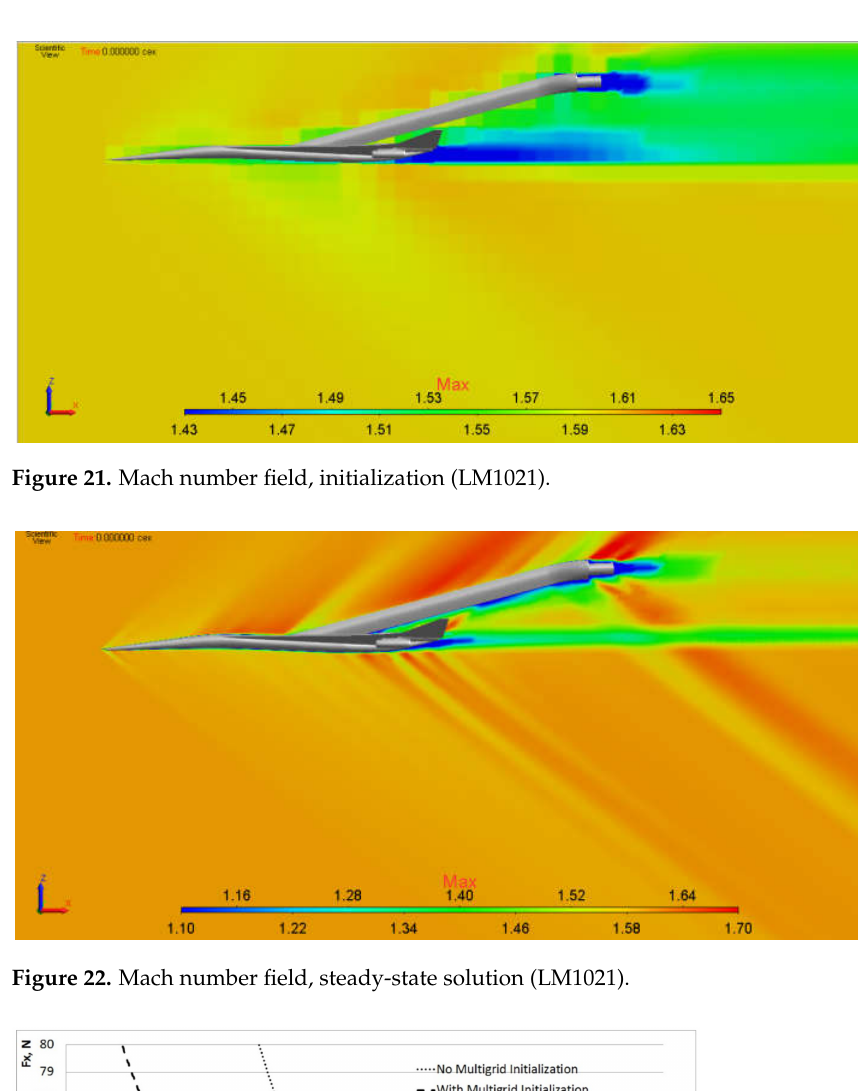
Figure 22. Mach number field, steady-state solution (LM1021).